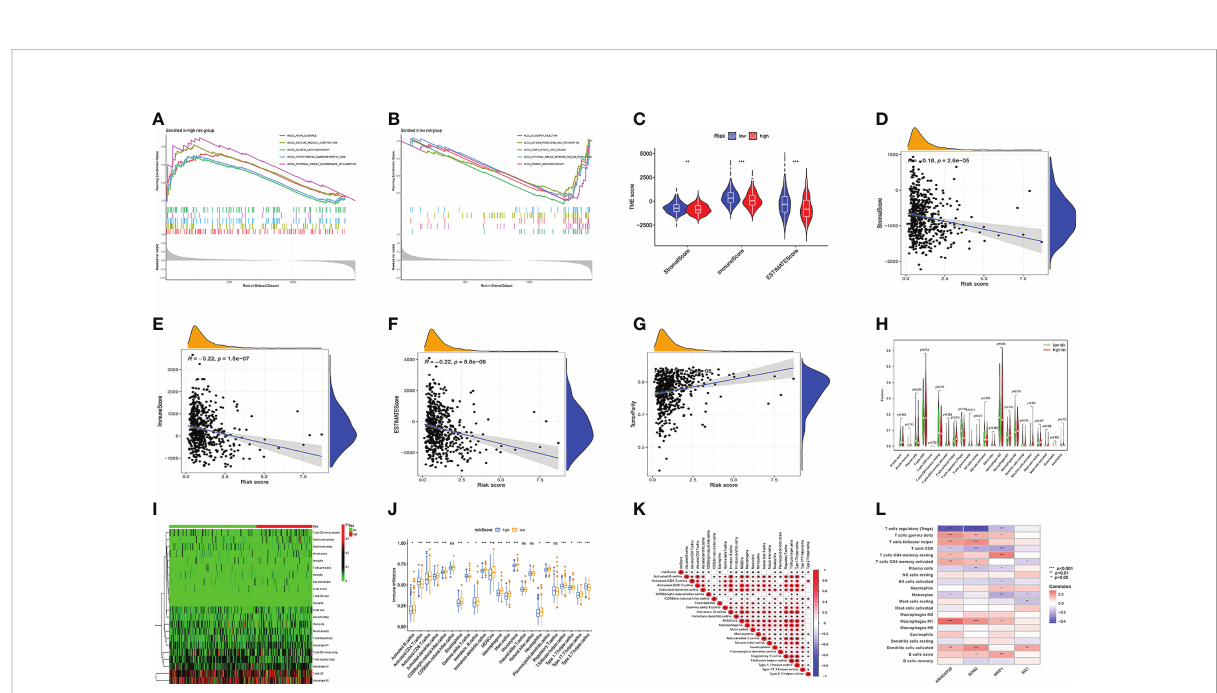
FIGURE 6 Model multi-omics analysis. (A, B) GSEA enrichment analysis. (C-F) TME analysis. the low-risk group had higher StromalScore, ImmuneScore, and ESTIMATEScore. Risk Score is inversely proportional to StromalScore, ImmuneScore, and ESTIMATEScore, and proportional to TumorPurity. (G-I) The amount of immune cell in fi ltration differed signi fi cantly. (J) Immune cell in fi ltration and risk score were linked. (K) immune cells and Risk score were linked. (L) immune cells and model genes were linked. Adjusted p-values were shown as ns, not signi fi cant; *p < 0.05; **p < 0.01; ***p <